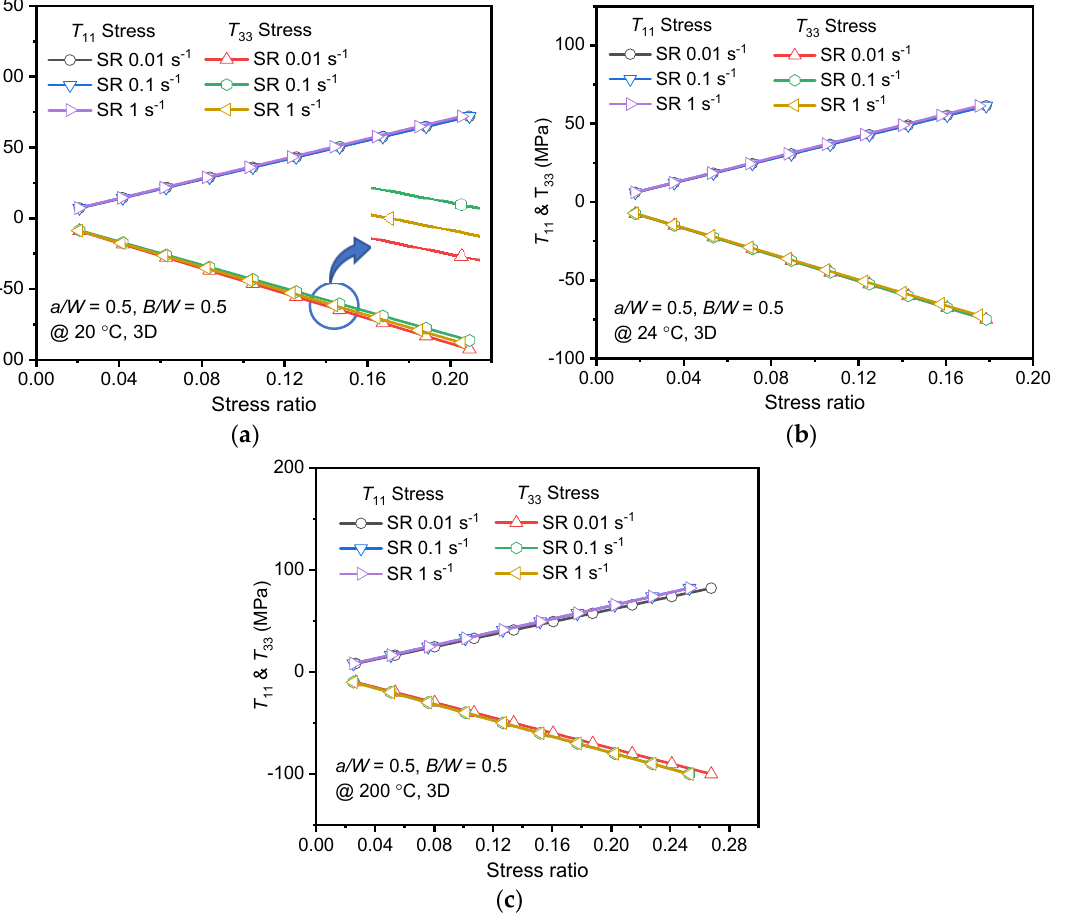
Figure 8. T 11 and T 33 at specimen thickness center obtained using FEA for different strain rates vs. Stress ratio ( a ) @ -20 0 C; ( b ) 24 0 C; ( c ) 200 0 C